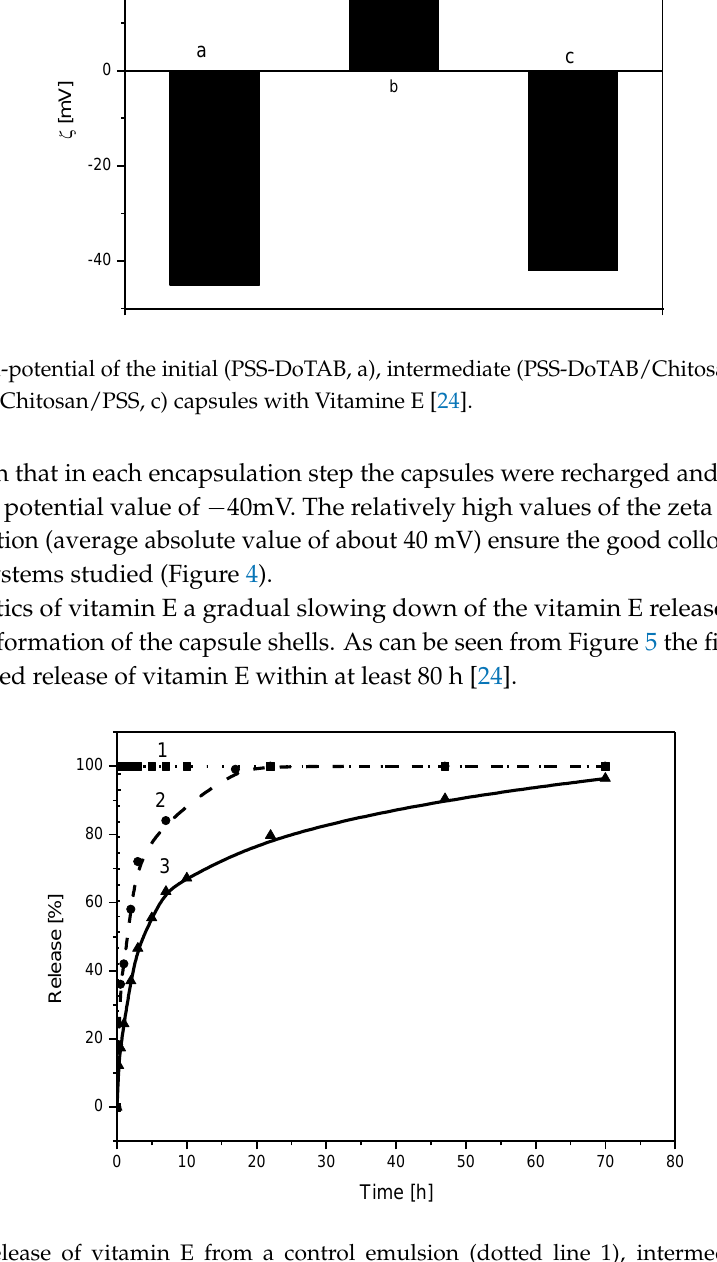
Figure 5. Release of vitamin E from a control emulsion (dotted line 1), intermediate capsules (dashed line 2), and final capsules (solid line 3) into a 50% aqueous ethanol solution [24].